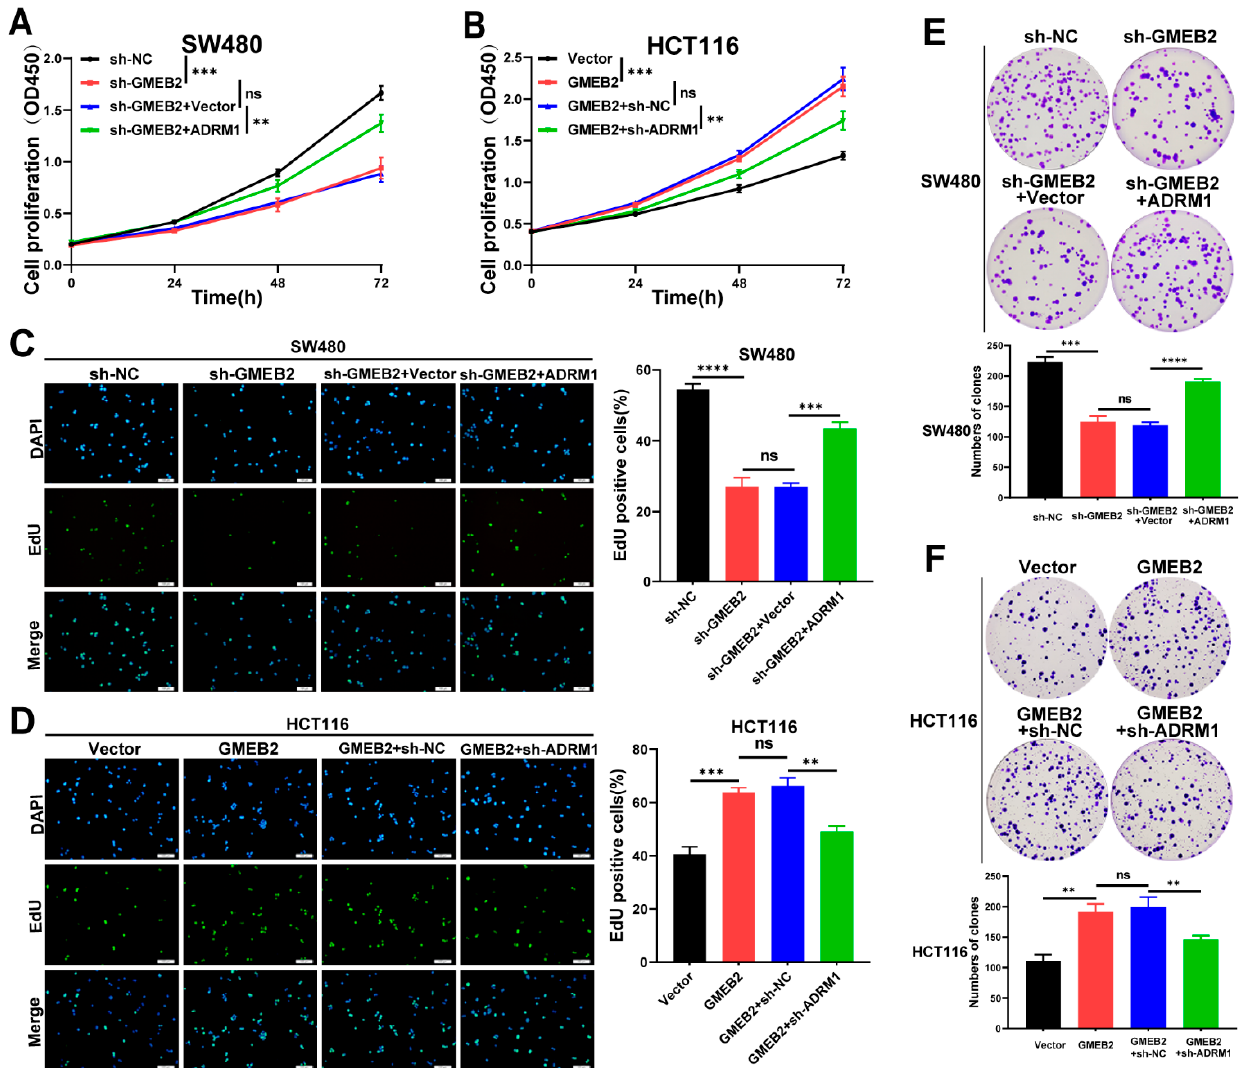
Figure 4. ADRM1 is essential for GMEB2-mediated CRC cell proliferation. ( A , C , E ) GMEB2-knockdown SW480 cells were transfected with the ADRM1-overexpressing plasmid for 48h, and the cell proliferation ability was quantified using the CCK-8, EdU and colony formation assays (Student’s t -test, ns p > 0.05, ** p < 0.01, *** p < 0.001, **** p < 0.0001). ( B , D , F ) GMEB2-overexpressing HCT116 cells were transfected with ADRM1 shRNA for 48h, and the cell proliferation ability was quantified using the CCK-8, EdU and colony formation assays (Student’s t -test, ns p > 0.05, ** p < 0.01, *** p < 0.001). The results are presented as the mean ± S.D. of three independent experiments. p < 0.05. Scale bar, 100 μ m.